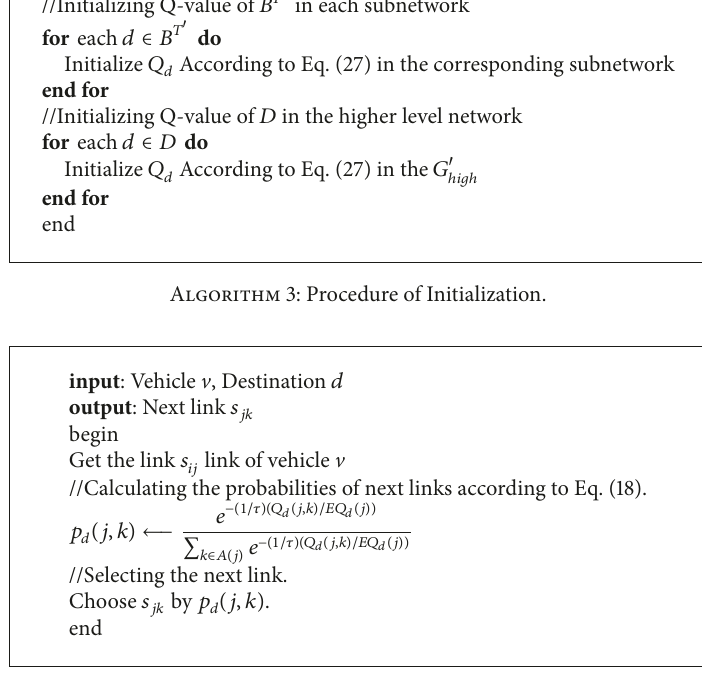
Algorithm 4: Procedure of Route